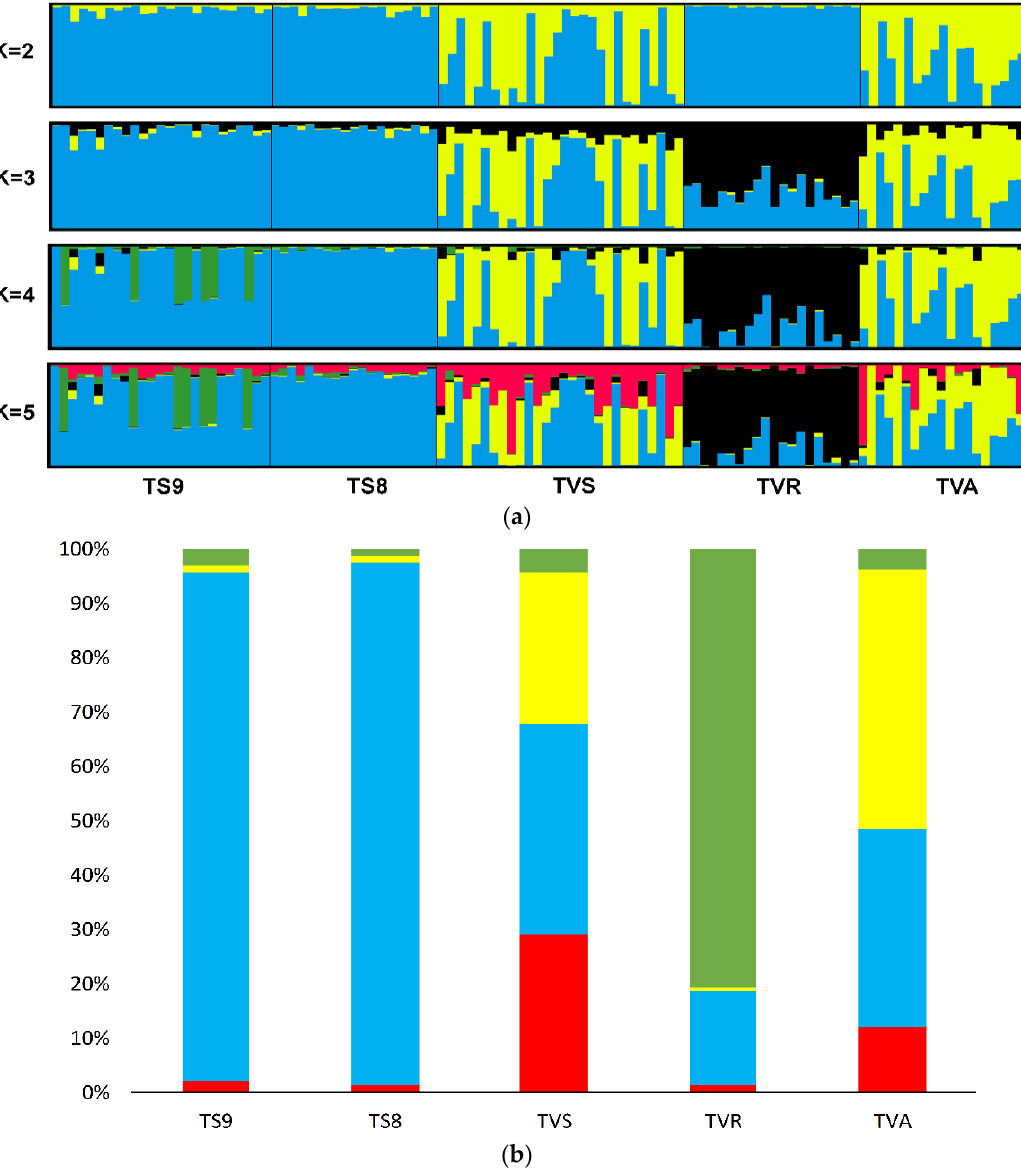
Figure 2. ( a ) Population structure of Vistula sea trout based on Bayesian clustering analysis for the set of all loci: Computations from 5 independent runs were treated in CLUMPP 1.1.2 and plotted with DISTRUCT 1.1. Each line corresponds to an individual. ( b ) Proportion of membership of each predefined population in each of the 4 clusters estimated in STRUCTURE.